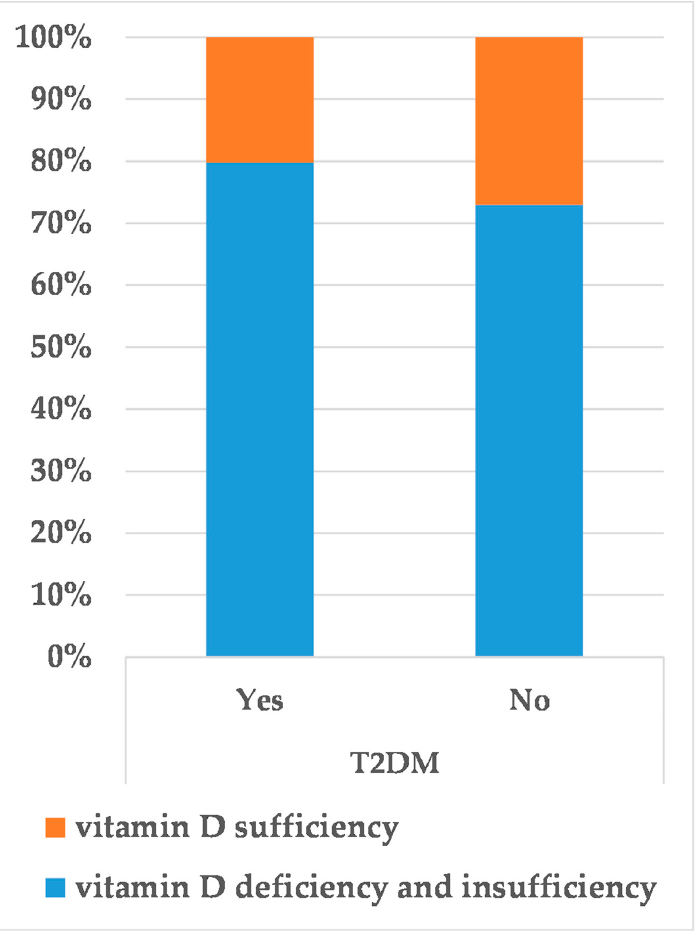
Figure 3. The proportion of T2DM prevalence in different 25(OH)D 3 levels.